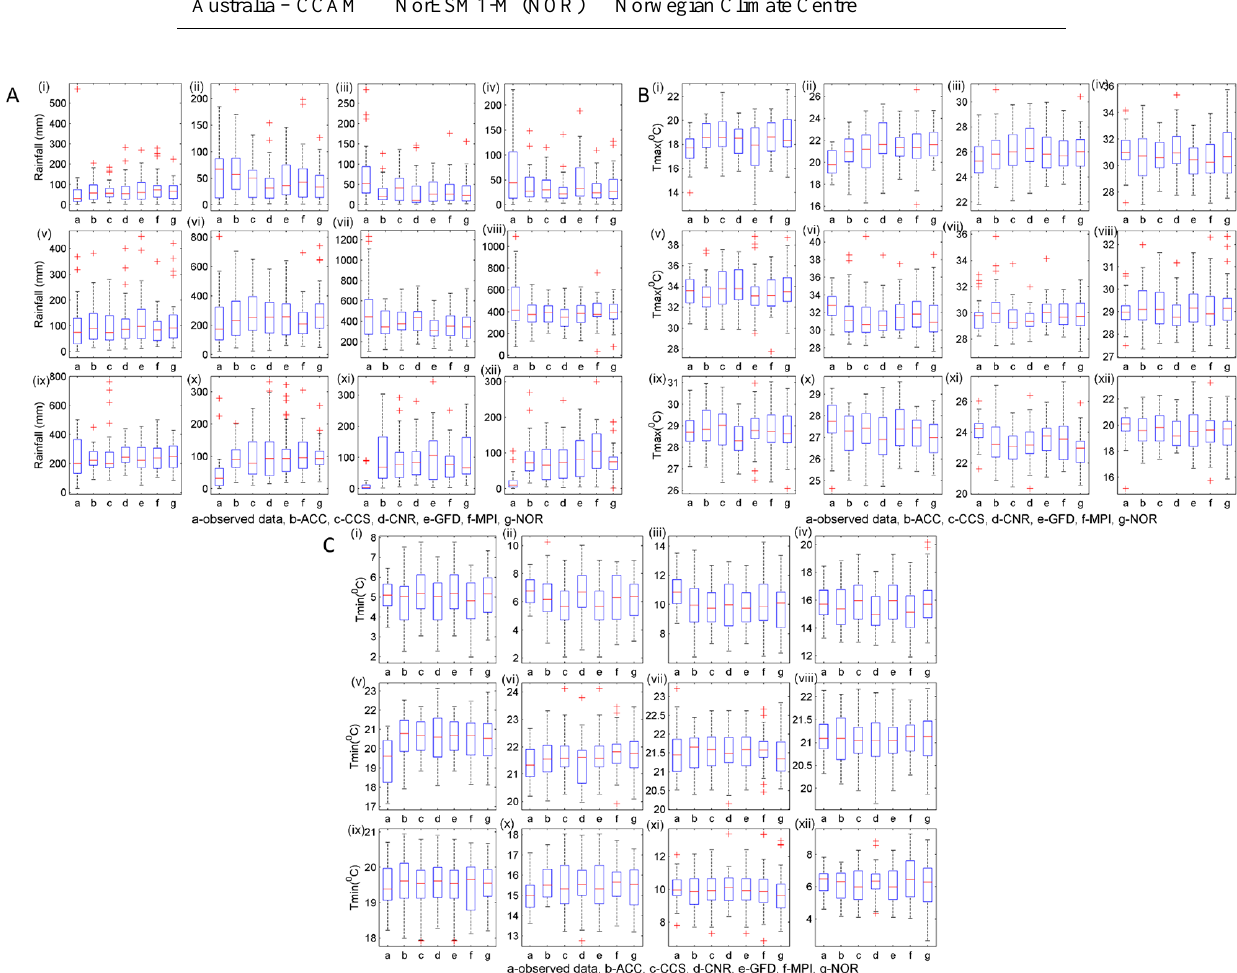
Figure 3. GCMs climatology compared with observed climatology for monthly (a) rainfall, (b) maximum temperature and (c) minimum temperature from 1971 to 2005 (represented from January to December as